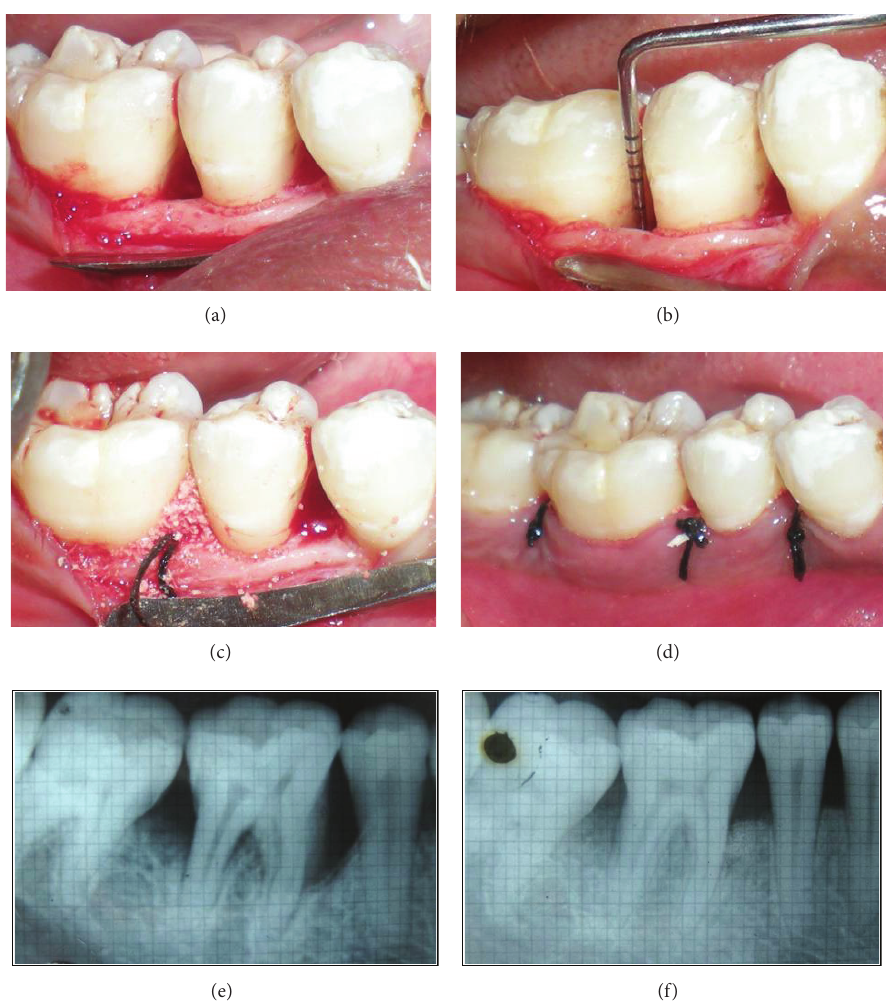
Figure 1: (a) Preoperative view. (b) Configuration and depth of defect. (c) Placement of rh-PDGF-BB in combination with 𝛽 -TCP. (d) Suturing. (e) Preoperative radiograph. (f) Postoperative